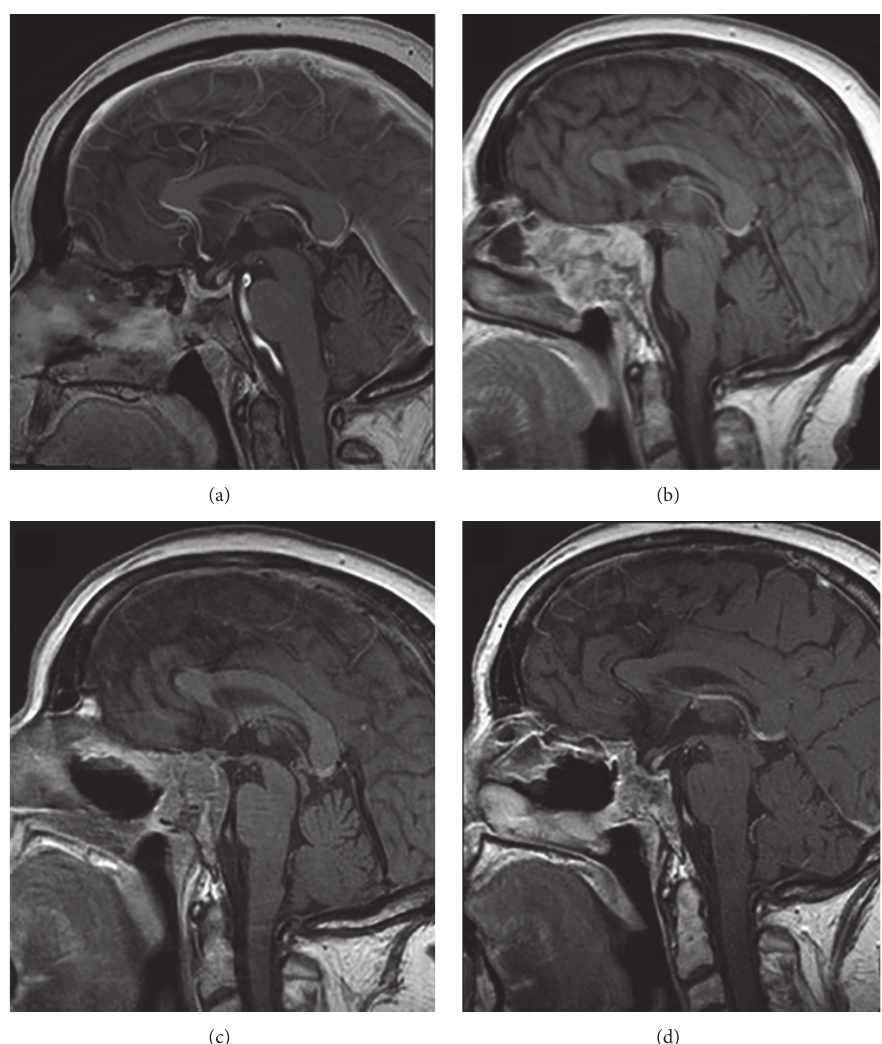
Figure 1: Pituitary MRI appearances (T1 postgadolinium weighted sagittal images). (a) After the first transsphenoidal operation for macrocorticotropinoma in 2010 with a small tumor remnant. (b) Three years after the first operation. Pituitary adenoma with destruction of the floor of the sella and invasion into sphenoid sinus and both cavernous sinuses. (c) Three months after the initiation of the concurrent therapy with TMZ and radiotherapy. (d) After the 6 cycles of TMZ. Stable pituitary remnant and biochemical control of the